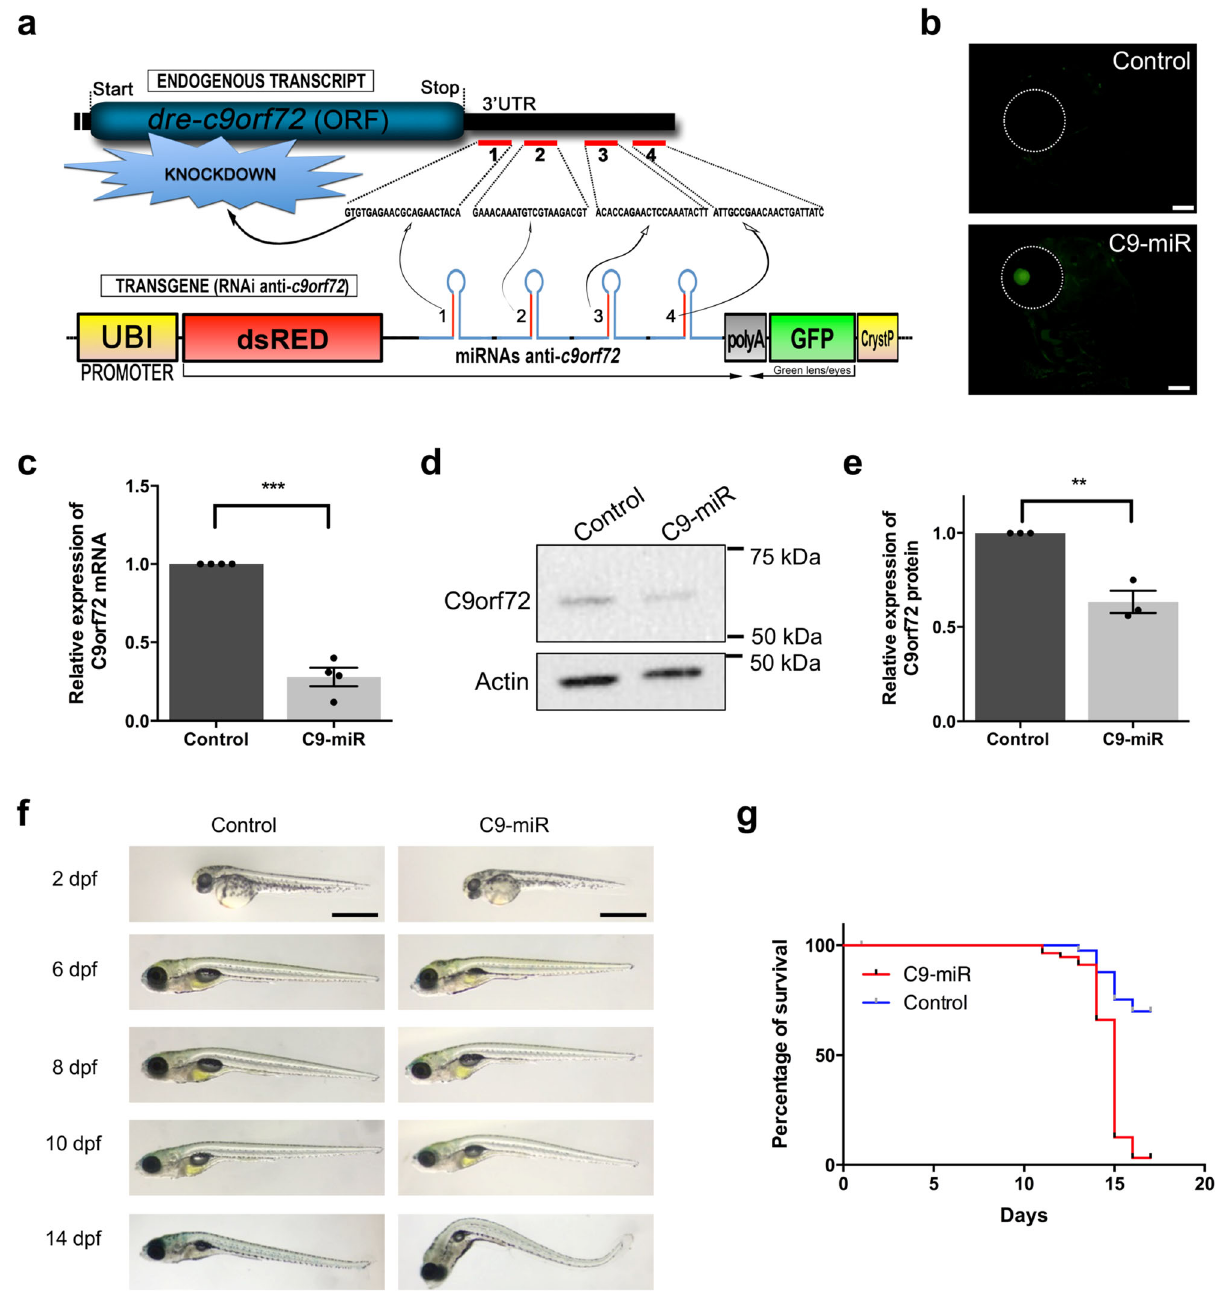
Fig. 1 Generation of a stable zebra fi sh C9orf72 knockdown line. a Schematic representation of the technique used to silence C9orf72 in zebra fi sh. The transgene is designed to express four different micro-RNAs targeting C9orf72 ’ s 3 ’ UTR and triggering knockdown by both repressing C9orf72 translation and affecting its stability. b Images demonstrating proper eGFP expression in the crystallin of the transgenic fi sh, a marker used to identify carrier/ knockdown larvae. Scale bar = 100 μ m. c Bar graph shows the relative expression of the endogenous C9orf72 gene. mRNA was normalized to elf1 α mRNA levels ( N = 4, *** p < 0.0001, Student ’ s t test). d Immunoblotting of the zebra fi sh protein C9orf72 and beta-actin as control. e Bar graph shows the relative expression of the C9orf72 protein compared with actin between C9orf72 mutants and control line ( N = 3; ** p = 0.0034; Student ’ s t test). f Gross morphological analyses of wild-type control and C9orf72-LOF fi sh (C9-miR). g Kaplan – Meier survival plot over 17 days after fertilization (dpf) showing low survival of C9-miR compared to controls after 10 dpf ( N = 3, n = 25). Data are presented as mean ± SEM. n represents the number of fi sh, N represents the number of experimental